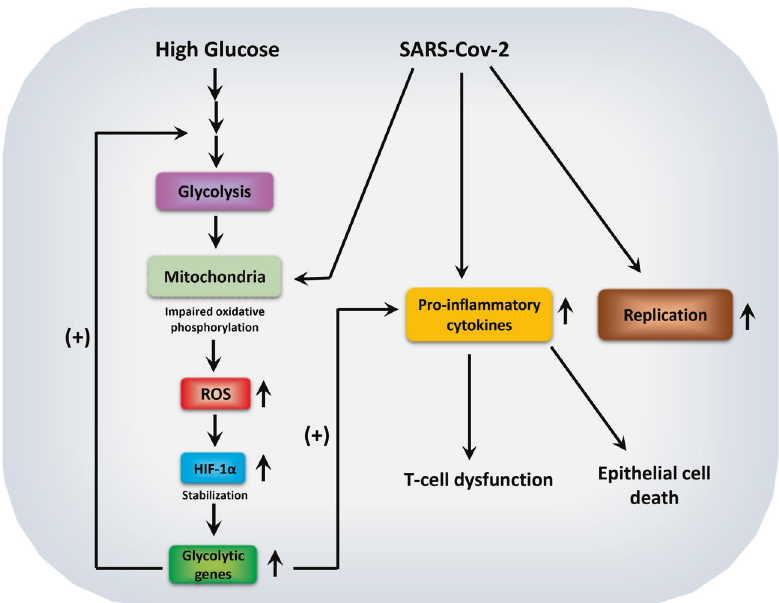
Fig. 1 Proposed model of how glucose induced metabolic reviewing potentiates SARS-Cov-2 replication and cytokine production. In metabolically stressed monocytes (cultured under high glucose condition), SARS-CoV-2 infection enhances glycolysis by aberrant production of mitochondrial ROS which leads to activation of transcription factor hypoxia-inducible factor-1 α (HIF-1 α ) to ensure its rapid replication. Such increased glucose metabolism through aerobic glycolysis fosters viral replication and cytokine production compromising T-cell response and function as well as induces lung epithelial cell